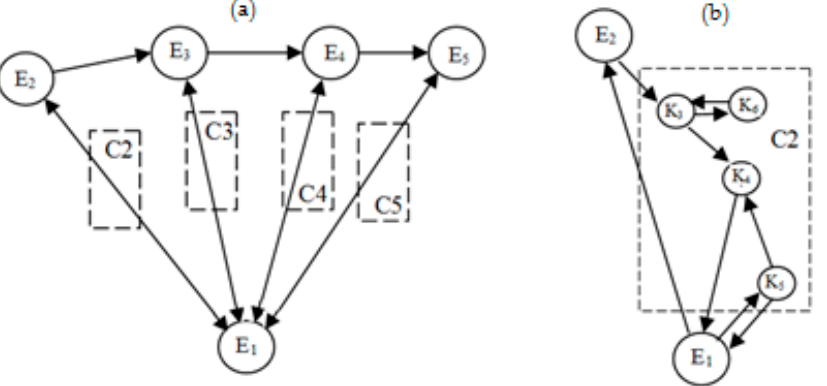
Figure 8. Graphs and subgraphs of the CTS operation model with full resource recovery: ( a ) with the control of four degradation states; ( b ) with the control of one degradation state (classical mod- el).